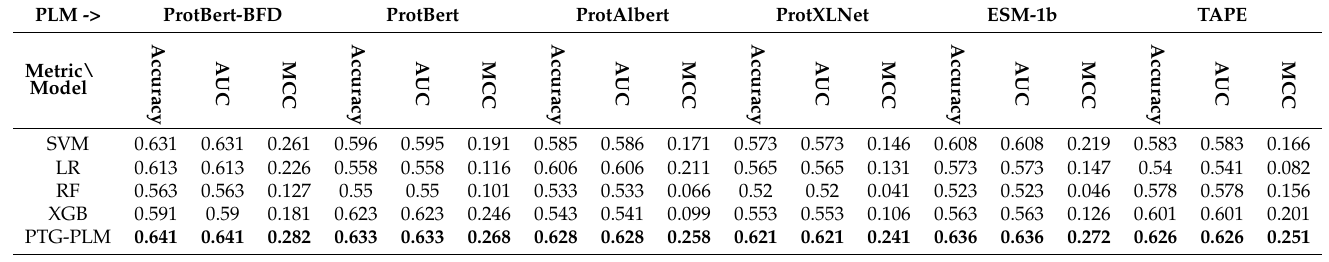
Table 8. Performance of PTG-PLM compared with four supervised learning methods on the Kgly independent dataset based on the six PLMs.